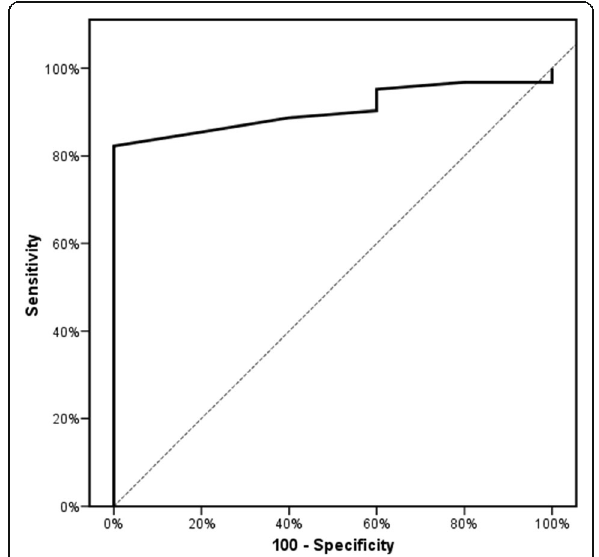
Fig. 2 ROC curve to assess agreement (sensitivity, specificity) of the ADC ratio to diagnose neoplastic from non-neoplastic lesions. Cutoff ADC ratio of > 0.41 × 10 − 3 mm 2 /s to diagnose neoplastic from non- neoplastic lesions can be used with a sensitivity of 85.48% and specificity of 80.00%